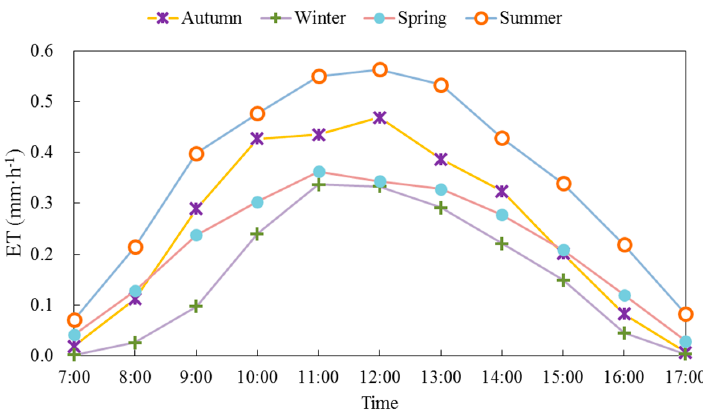
Figure 5. Diurnal variations of seasonal average ET of lawn in the four seasons.